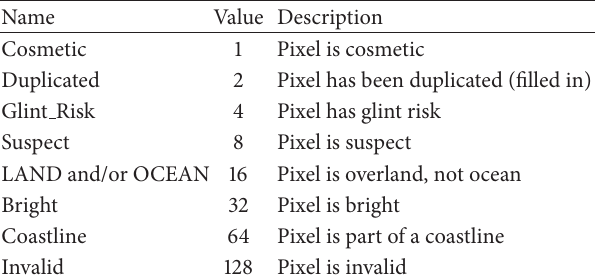
Table 1: Cloud probability maps corroborated flags of MERIS